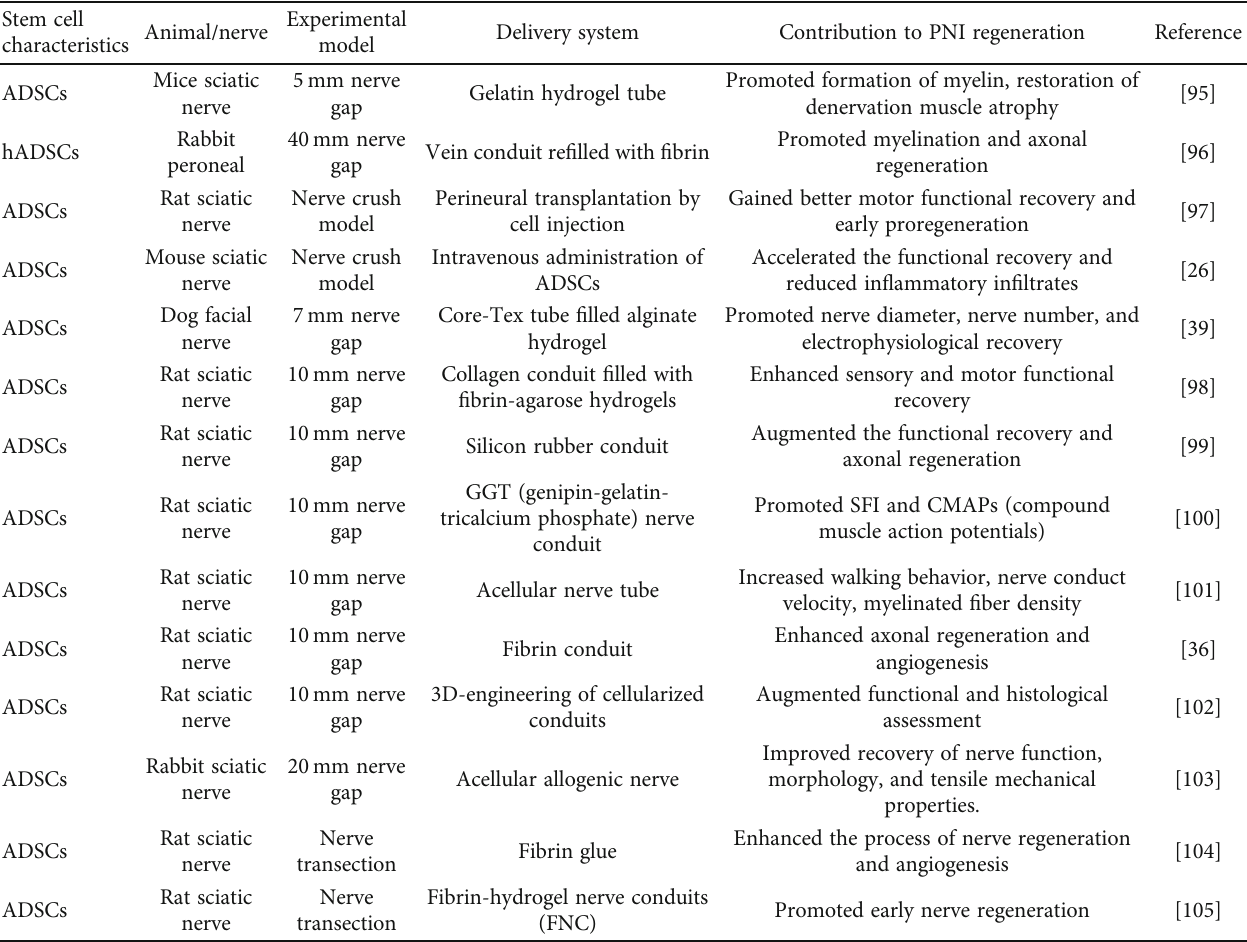
Table 1: E ff ect of ADSCs in PNI animal